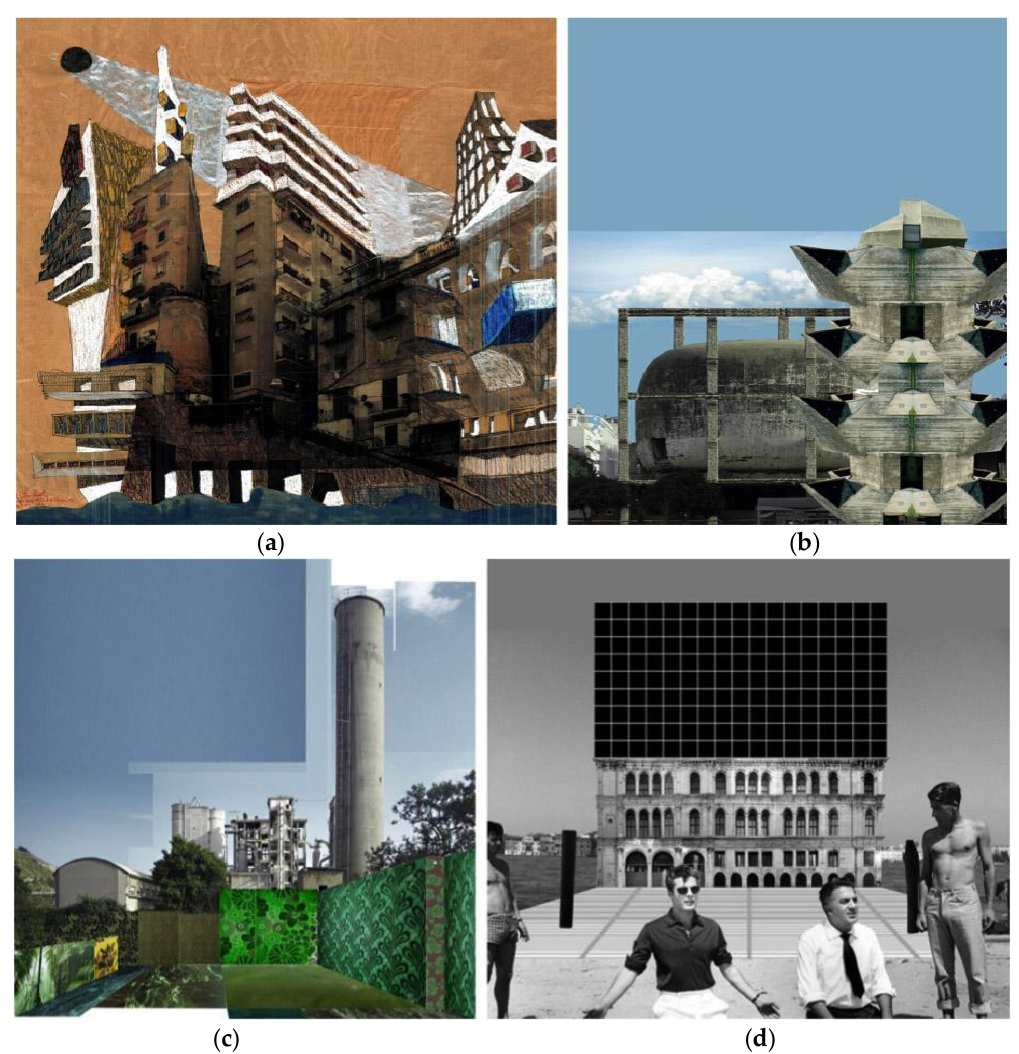
Figure 2. ( a ) Cherubino Gambardella, La vita con gli oggetti , 2011; ( b ) Luca Galofaro, Postcard from Beirut , 2013; ( c ) Beniamino Servino, Il giardino protetto , 2015; ( d ) Carmelo Baglivo, Palazzo veneziano ,